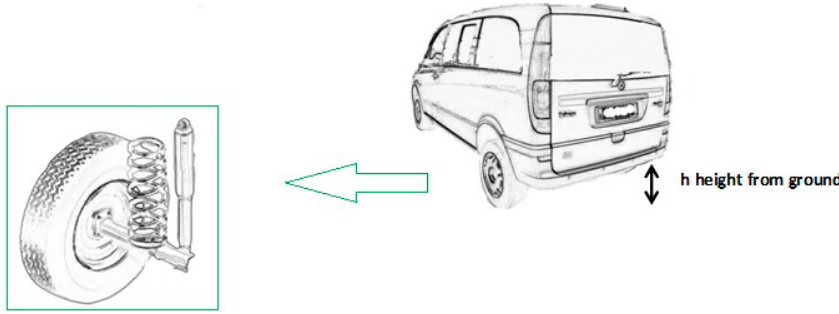
Figure 2. Example of vehicle where is installed the absorption measurement system, with a focus on the shock absorber.